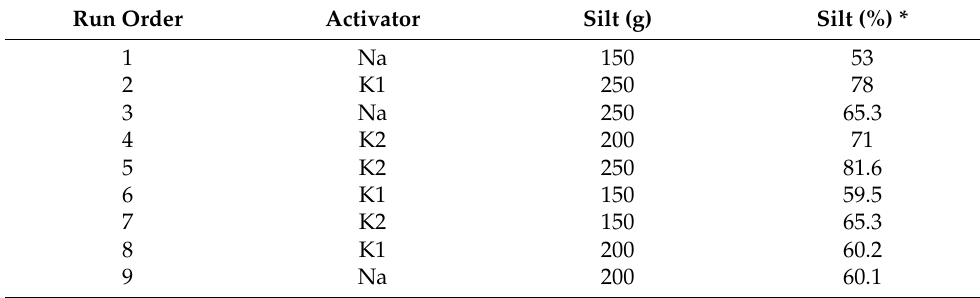
Table 4. The effect of silt amount and activator type on UCS (DOE).